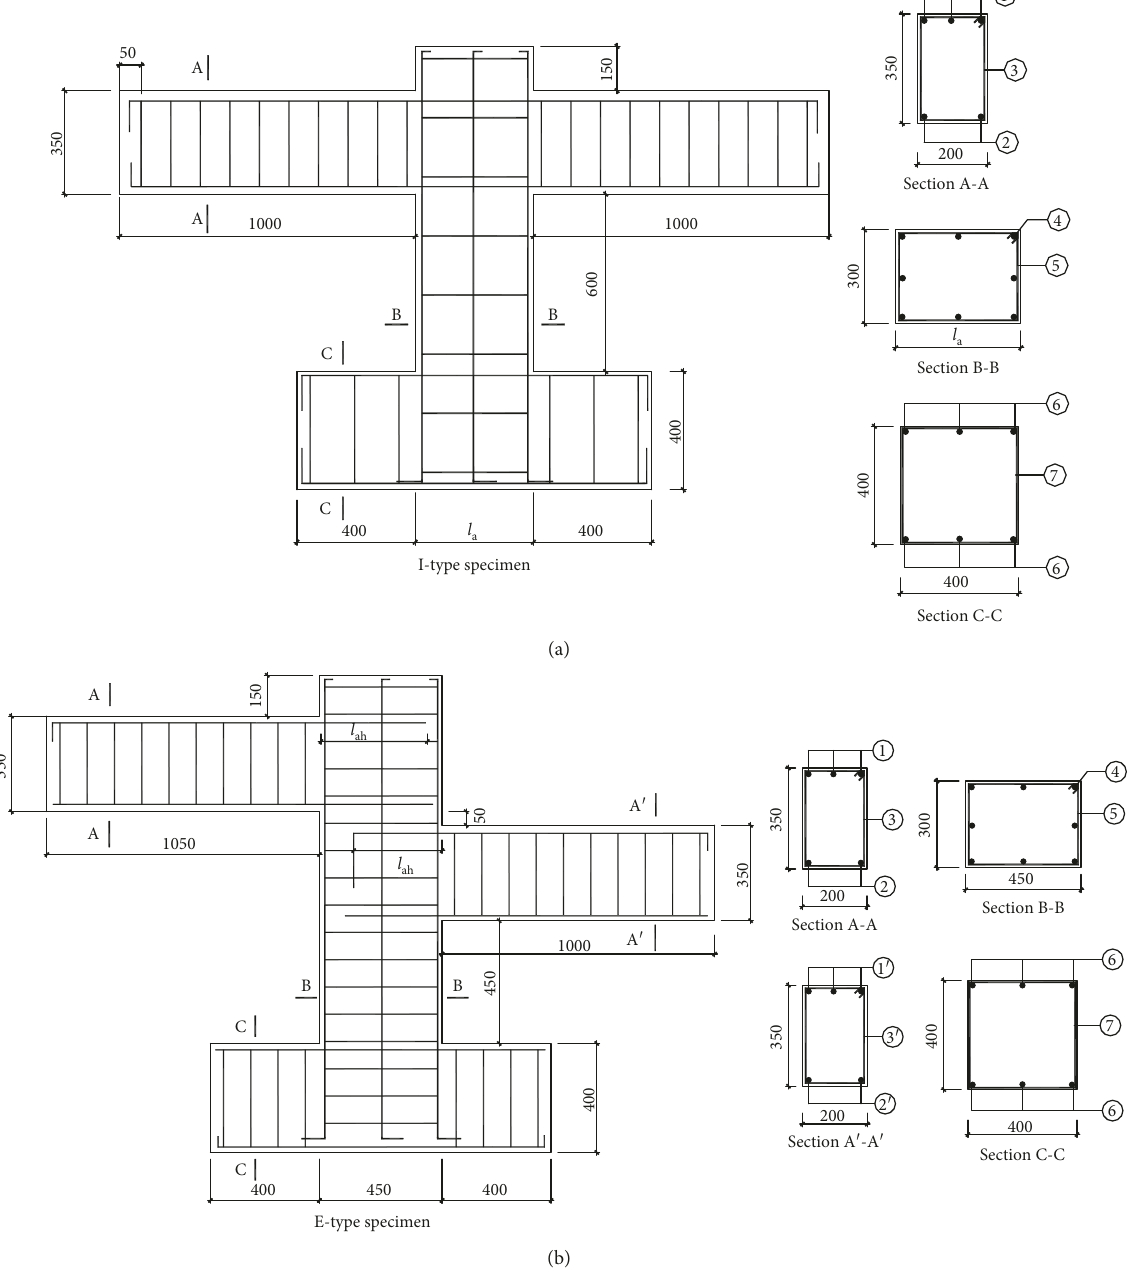
Figure 1: Details of the reinforcement arrangement and specimen size. (a) Interior beam-column connection. (b) Exterior beam-column